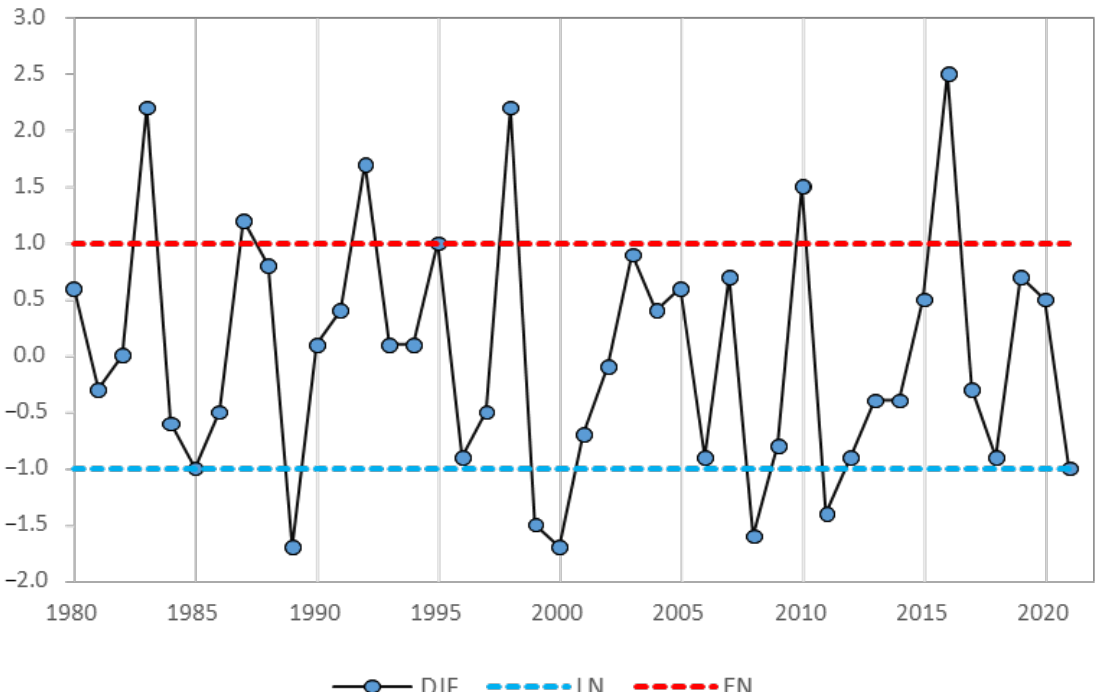
Figure 3. Classification of the ENSO conditions based on the January ONI series, which is noted as ONI_DJF in the following as it is based on the December–February NINO3.4 index values. The dashed lines represent the conditions when ONI_DJF = +1.0 and − 1.0, thus, respectively, defining the EN and LN events during 1980 – 2021.